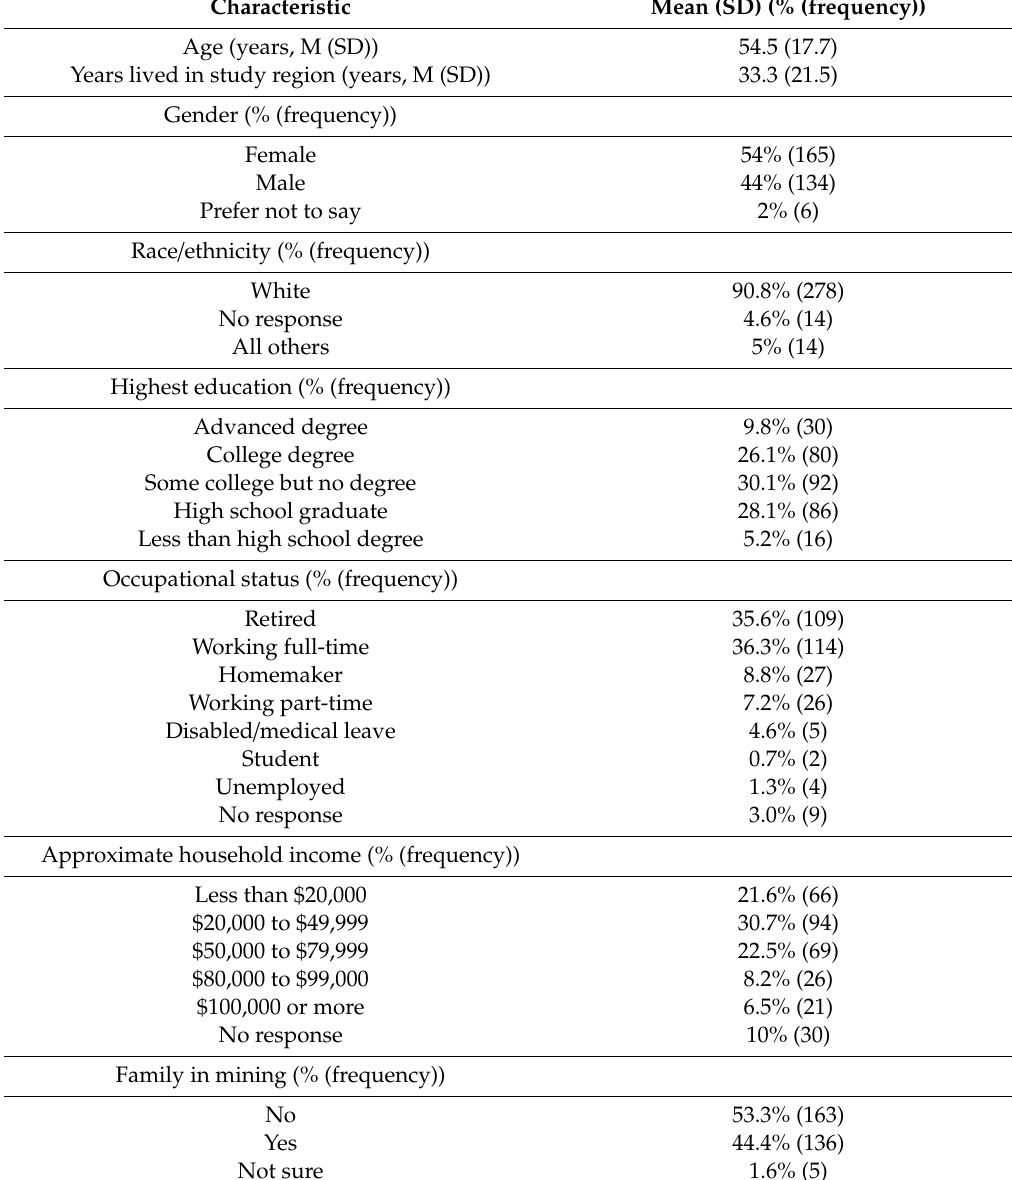
Table 2. Description of sample ( n =